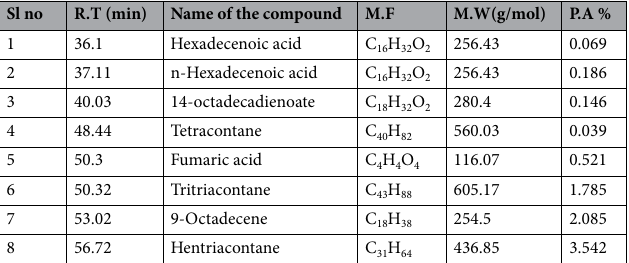
Sl no R.T (min) Name of the compound M.F